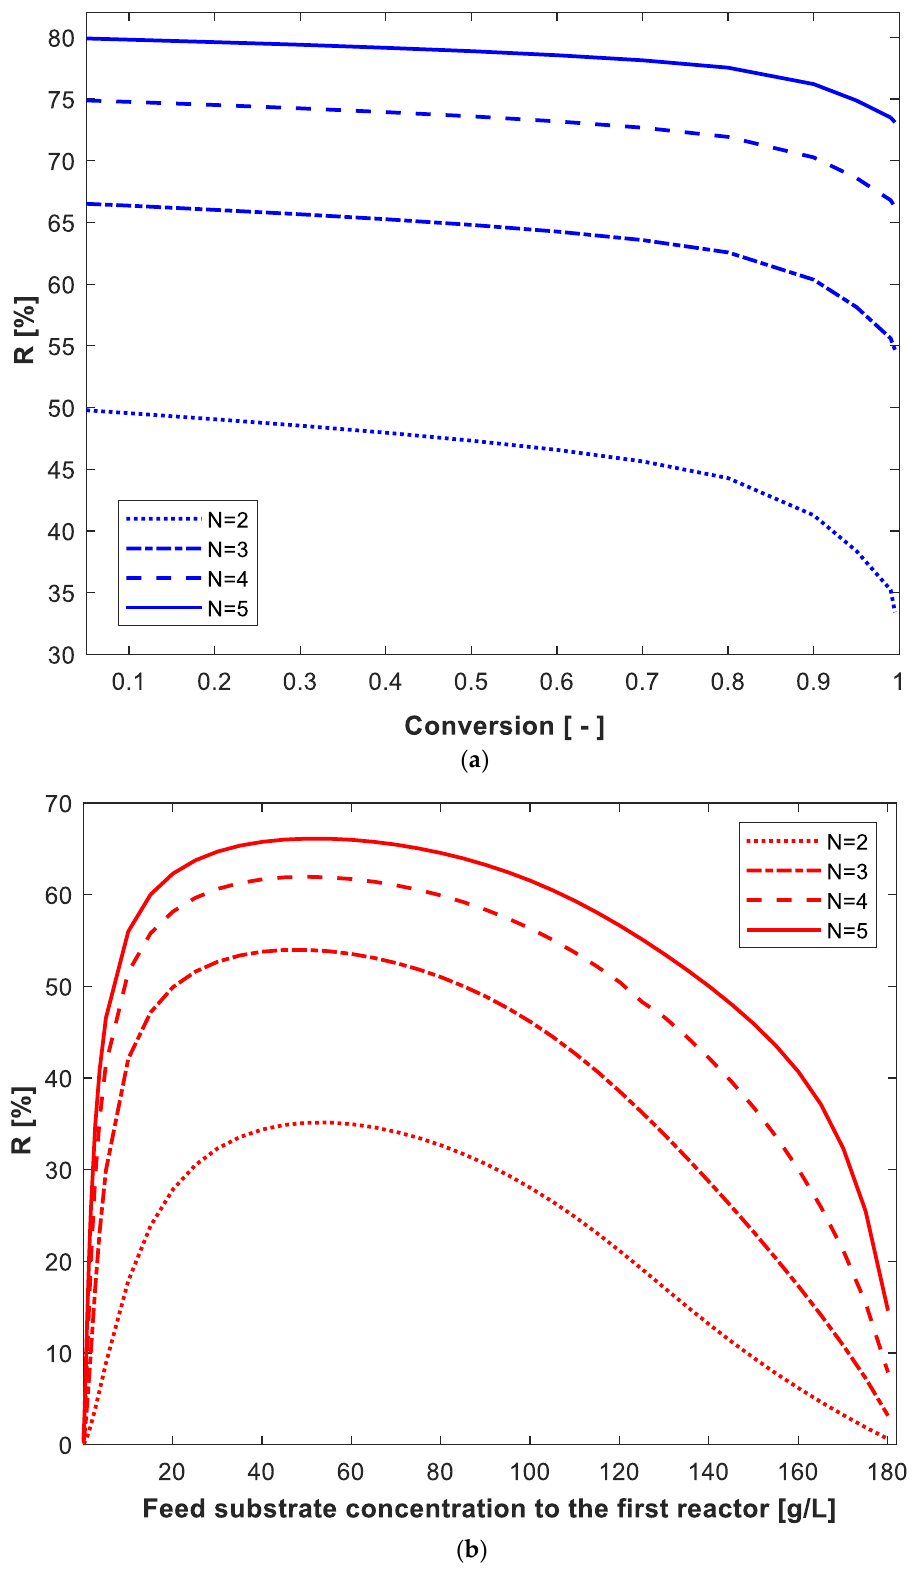
Figure 11. The percentage reduction in total volume using the optimum design versus equal-volume design criteria for N-reactor series as a function of conversion ( a ) and inlet substrate concentration ( b ). In ( a ), 𝑆 𝑜 = 50 g/L, X o = 0 g/L, 𝑃 𝑜 = 0 g/L; in ( b ), 99% conversion, X o = 0.01 g/L, 𝑃 𝑜 = 0 g/L. Table 2. Comparison of the current work simulation results with the literature. N Reactors/Equal or Fermentation Process Reactor Performance/Volume Ref. Unequal Size